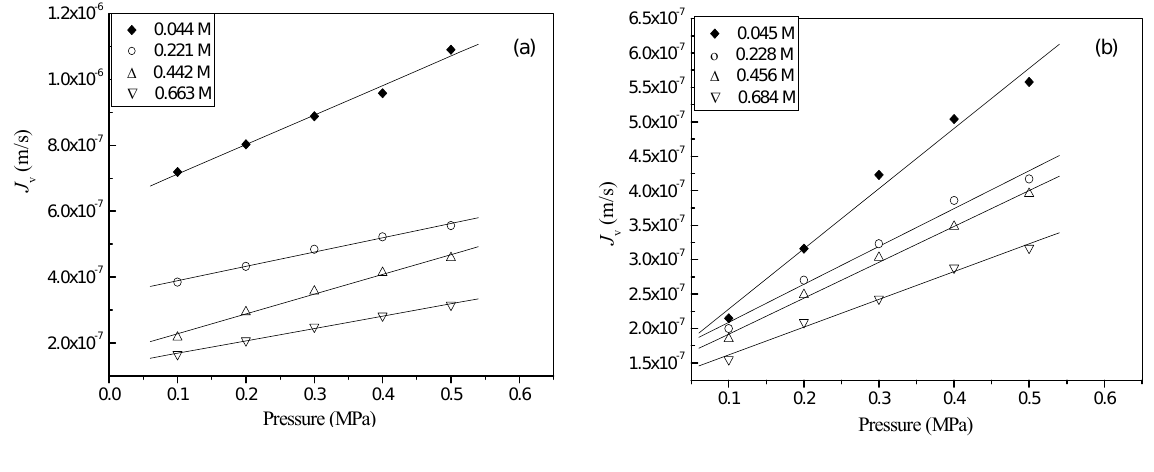
Figure 1. Dependence of volume flux on pressure for (a) [Bmim]BF [Bmim]Br